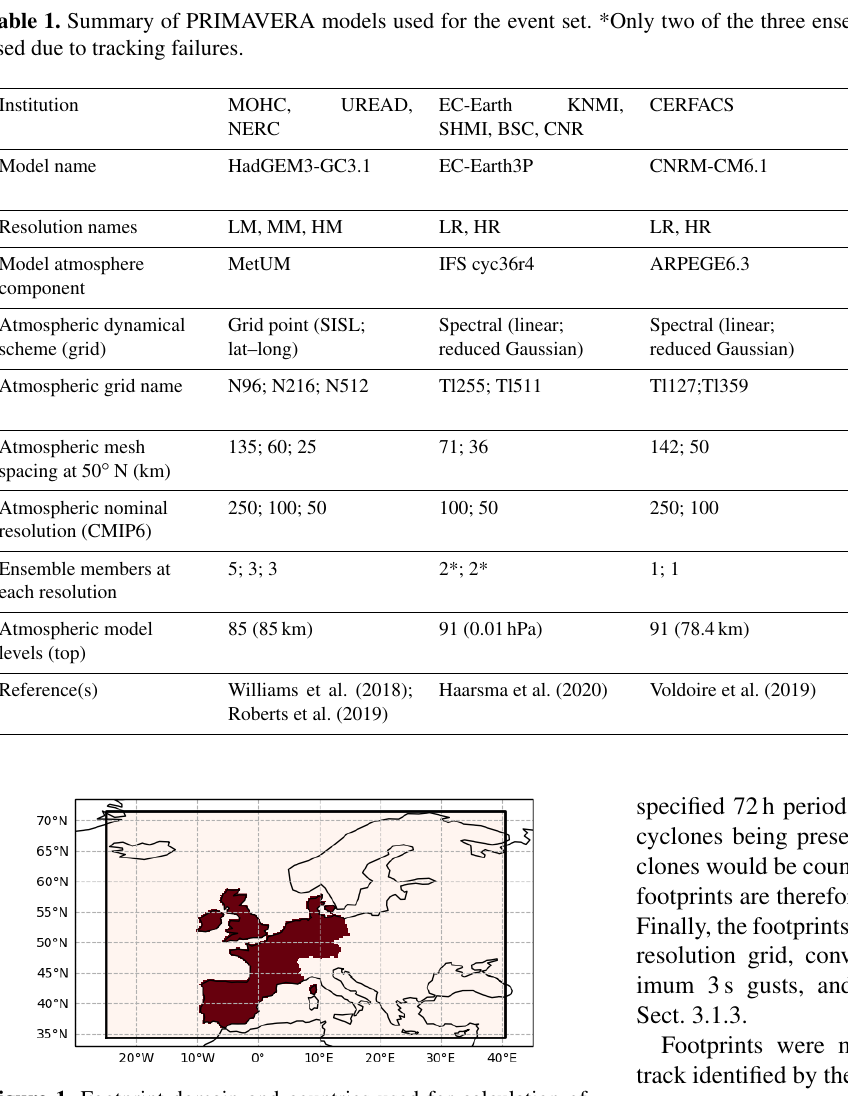
Figure 1. Footprint domain and countries used for calculation of loss